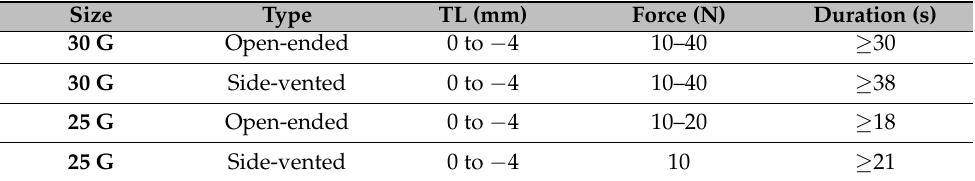
Table 2. Recommended irrigation procedure to reduce the risk of apical irrigant extrusion in teeth with an open